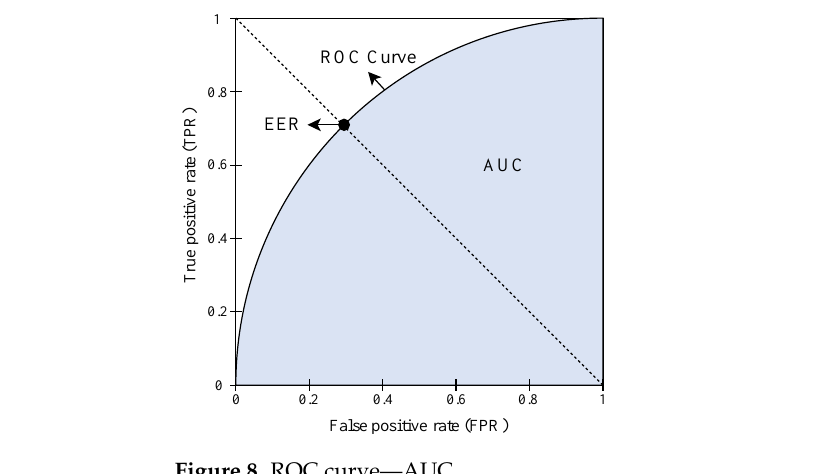
Figure 8. ROC curve—AUC. Table 15. AUC/EER comparison of the accuracies of the various techniques with frame-level